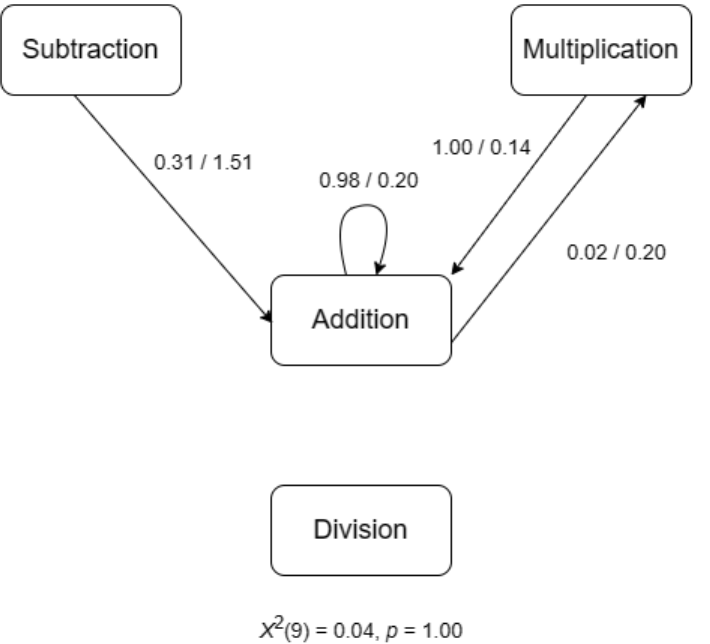
Figure 5. The sequential problem-solving behavior of stag hunters in terms of types of problem solved disclosed that stag hunters are more likely to choose an addition or multiplication arithmetic problems.